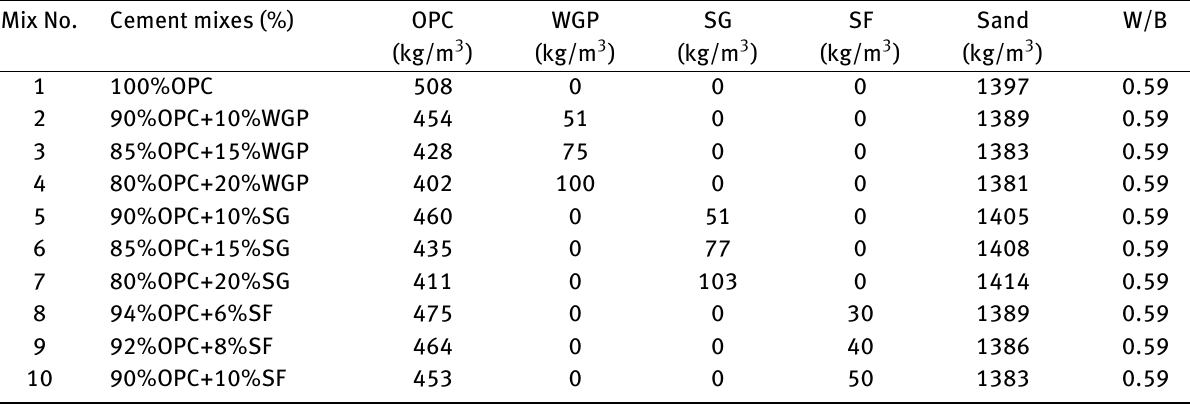
Table 4: Mortar mix proportions for measuring Pozzolanic activity. Mix